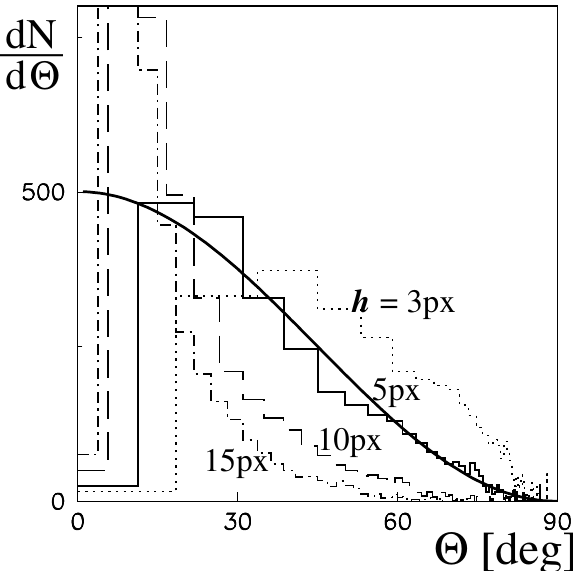
Figure 5. Zenith angle distribution obtained for various values of camera matrix thickness ( h ). The expected cos 2 ( Θ ) dependence is given by the thick line.